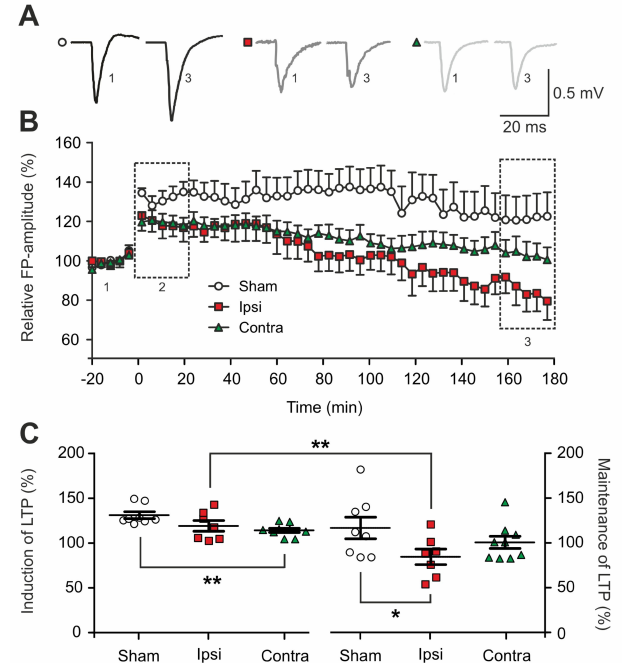
Figure 2. Impairment of long-term synaptic plasticity (late long-term potentiation (l-LTP)) in the early phase after traumatic brain injury (TBI). ( A ) Representative voltage traces of evoked extracellular field potentials (FPs) recorded before (Pre-TBS, baseline, 1 in ( B )) and after electrical theta-burst stimulation (TBS) (post-TBS, maintenance, 3 in ( B )) and under di ff erent experimental conditions at 1-2 days post-TBI (sham: n = 8 from 8 mice; ipsilateral: n = 7 from 7 mice; contralateral: n = 8 from 8 mice). ( B ) Time course of relative local field potentials (LFPs) amplitude pre- and post-TBS. After baseline recording (1), TBS protocol was applied and LFPs were recorded for 180 min; data points represent mean values of the electrophysiological recordings under di ff erent conditions (sham: n = 8 from 8 mice; ipsilateral: n = 7 from 7 mice; contralateral: n = 8 from 8 mice) relative to the recordings of the individual baseline, the error bars represent standard error of mean (SEM). The dashed rectangles represent the time windows considered for the induction (2: first 20 min of recording) and the maintenance of l-LTP (3: last 20 min of recording), as visualized in ( C ). The lesion significantly decayed the expression of ipsilateral l-LTP over the course of recording. ( C ) Scatter plots showing the induction (2 in ( B )) and the maintenance (3 in ( B )) of l-LTP in the di ff erent experimental conditions over a recording period of 20 min; data points represent the relative values of baseline stimulation acquired during the induction phase ( C left) in the first 20 min post-TBS and the maintenance phase ( C right) during the last 20 min; mean and SEM are indicated by the black horizontal lines. The asterisks indicate the significance of the tested data in one-way analysis of variance (ANOVA) and post hoc least significant di ff erence (LSD), significantly di ff erent values are indicated as *: p < 0.05, **: p <